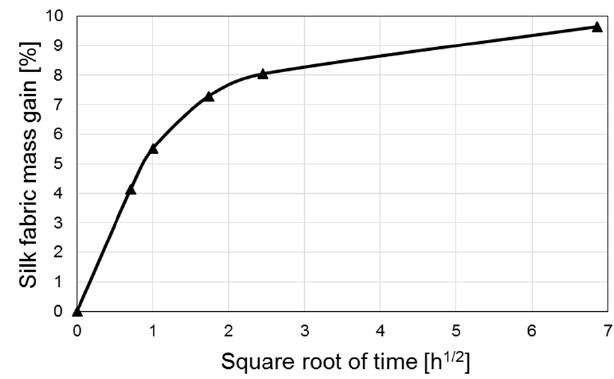
Figure 12. Moisture absorption curve of silk fabric exposed to a humid environment at 35 °C.